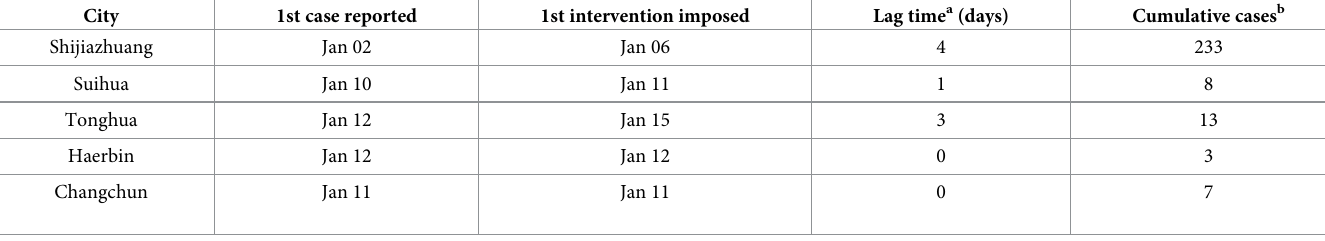
Table 1. The description of COVID-19 epidemic before imposing NPIs in five worst-hit cities in China, Jan-Feb 2021. City 1st case